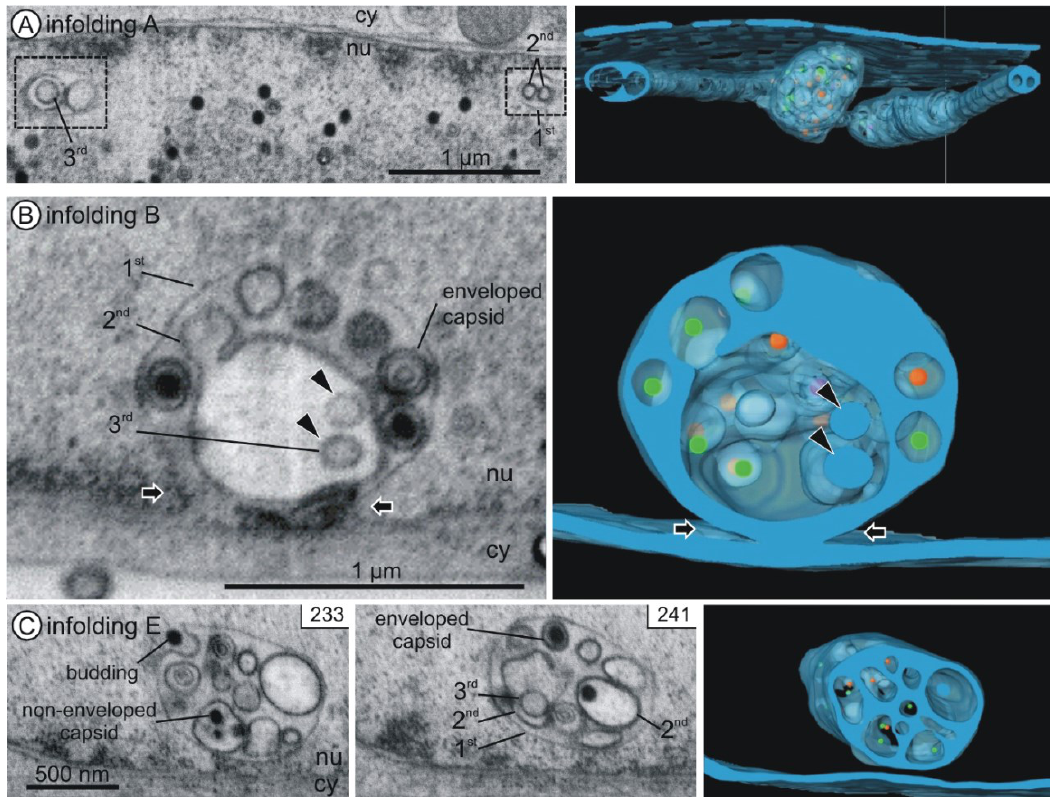
Figure 4. Internal structure of nuclear infoldings. Left and middle panels: FIB/SEM micrographs of the reconstructed details. See also Movies S1 and S2. Right panels: Three-dimensional reconstructions. Nuclear infoldings (semi-transparent blue) and capsids inside the infoldings (A capsids purple; B capsids orange; C capsids green). ( A ) Infolding A. Cross sections through two tubular segments (1st order infoldings) with 2nd order infoldings and a 3rd order infolding. Three-dimensional imaging reveals the tubular shape of the 2nd order infoldings and the spherical shape of the 3rd order infolding. ( B ) Connection of infolding B with the inner nuclear membrane (black arrows). Vesicles (2nd order infoldings) and three enveloped capsids are visible within the 1st order infolding. The 2nd order infolding contains two 3rd order infoldings (black arrowheads). ( C ) Infolding E with 1st, 2nd and 3rd order infoldings, a budding capsid, enveloped capsids in 1st order infoldings and non-enveloped capsids in 2nd order infoldings. nu nucleoplasm, cy cytoplasm.